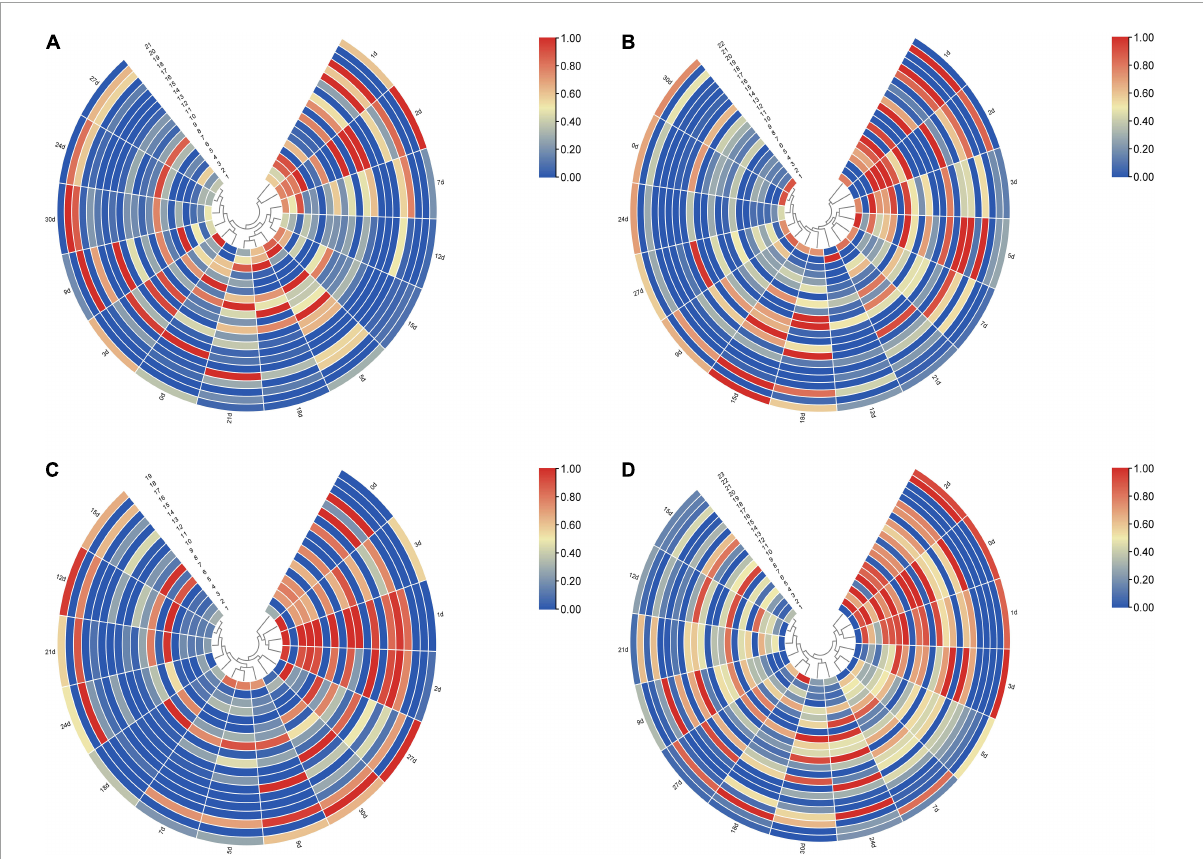
FIGURE3 The clustering heat map based on the peak heights of polypeptide fragments in different organs. (A) Lung samples could be divided into five different stages, 0 and 3 days, 1 and 2 days, 5, 18, and 21 days, 7, 12, and 15 days, and 9, 24, 27, and 30 days were divided together, respectively. (B) Liver samples could be divided into five different stages, 1 and 2, 3, and 5 days, 7 and 21 days, 12 days, and 0, 9, 15, 18, 24, 27, and 30 days were divided together, respectively. (C) Kidney samples could be divided into four different stages, 0 to –3 days, 5, 7, and 9 days, 12, 15, 18, 21, and 24 days, and 27 and 30 days were divided together, respectively. (D) Skeletal muscle samples could be divided into five different stages, 0–2 days, 3, 5, and 7 days, 9, 12, 15, and 21 days, 18 and 27 days, and 24 and 30 days were divided together,